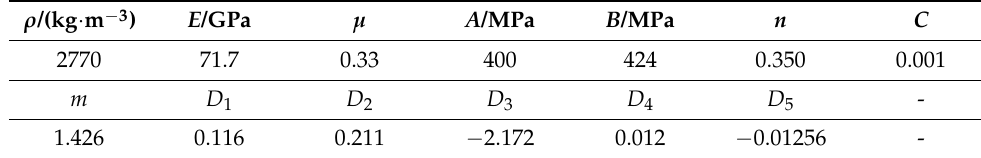
Table 1. Material parameters of 2A12 aluminum alloy